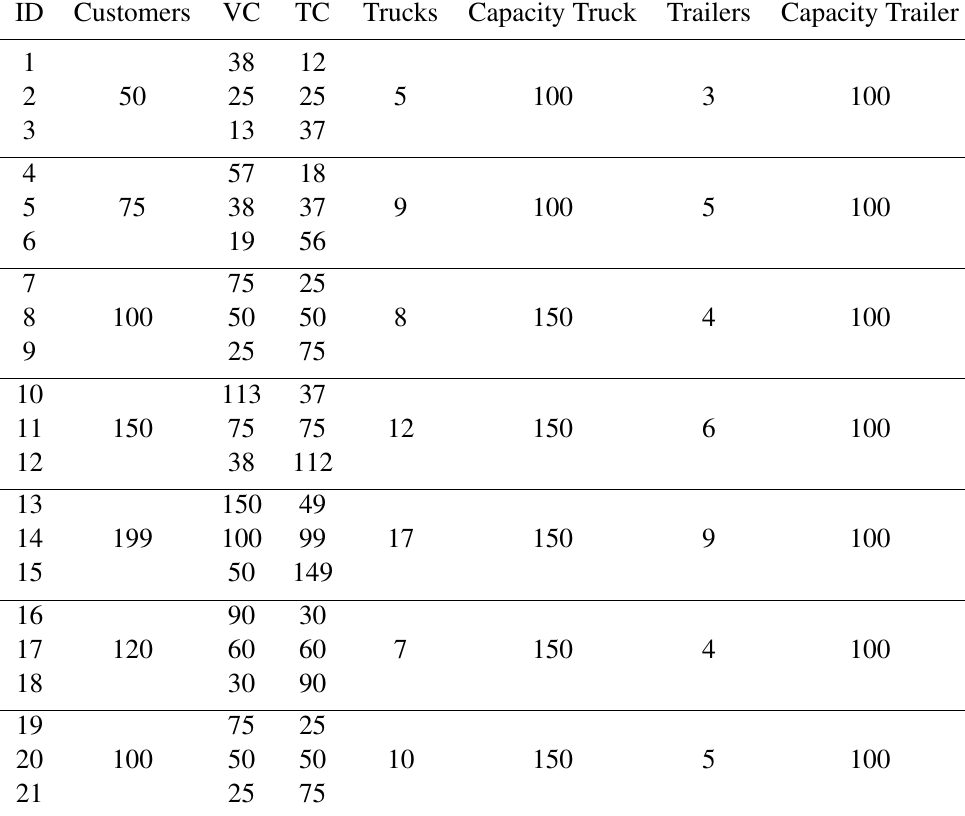
Table 1: TTRP benchmark data reported by Chao